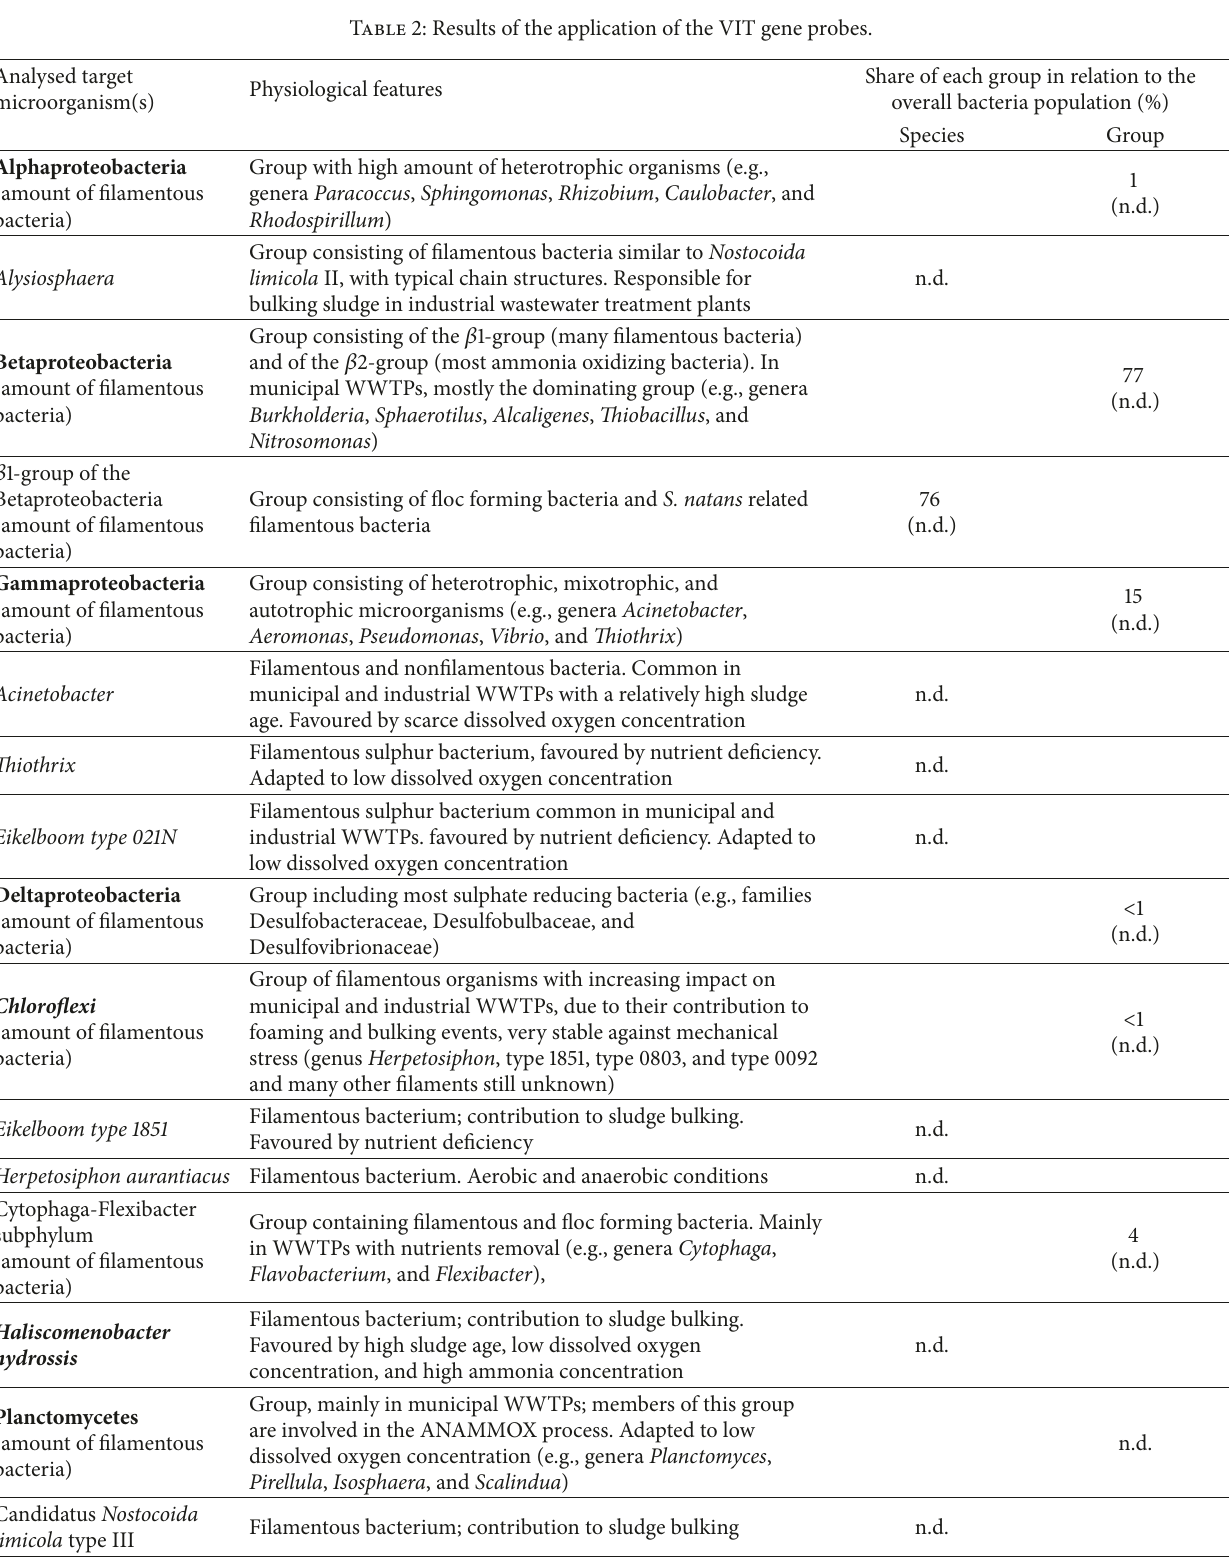
Table 2: Results of the application of the VIT gene